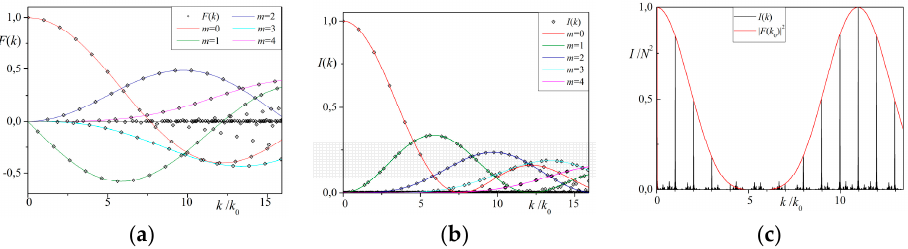
Figure 4. ( a ) Structure factor (cid:1832)((cid:1863)) calculated using formula (14) and ( b ) Diffraction intensities (cid:1835)((cid:1863)) calculated as squared formula (14) for harmonically modulated structure with single modulation term ( A = 0.2, a = 1.0, ξ = τ ). Due to known property of Bessel functions, J − m ( z ) = − J m ( z ) , the peaks presented in I ( k ) plot are doubled. First 5 envelopes marked with different colors. ( c ) Diffraction pattern of the Thue-Morse sequence with Bragg component (envelope function calculated as squared formula (15) for (cid:1863) (cid:2868) = (cid:2870)(cid:3095) (cid:2869).(cid:2869) ≈ 5.71 [ a . u . ] and b = 0.1, marked with red) and singular continuous component. The full diffraction pattern (both components) I ( k ) are plotted with black line.